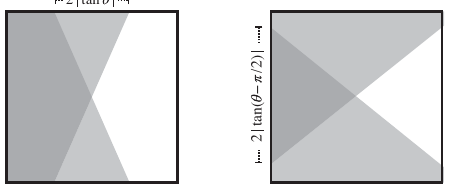
FIG. 15. The twirling ϕ C ð p θ Þ for two cases. Left: j θ j ∈ ½ð π = 4 Þ ; ð 3 π = 4 Þ(cid:2) . Right: ϕ C ð p θ Þ for j θ j ∈ ½ − π ; π (cid:2)n½ð π = 4 Þ